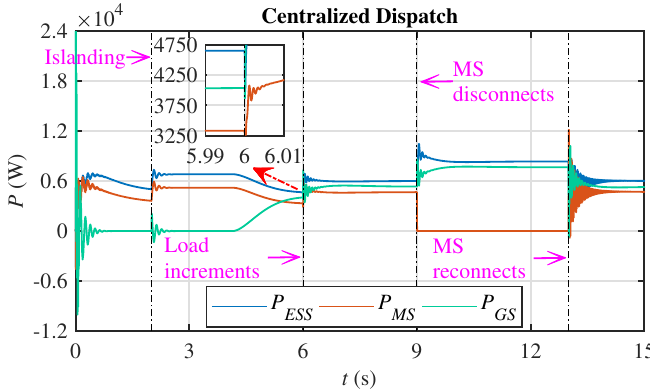
Figure 12. Power outputs of DGUs.